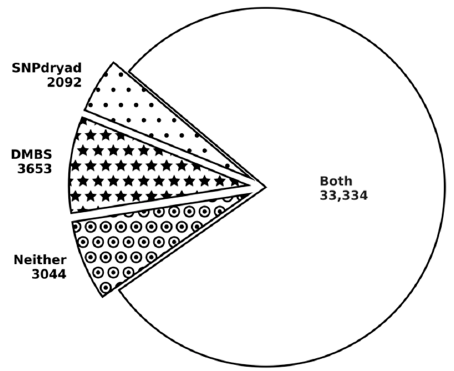
Figure 4. Comparison of the predictions by DMBS and SNPdryad on the HumVar dataset. 3.4. Comparison with Current Predictors on the SNPdbe and ExoVar Datasets